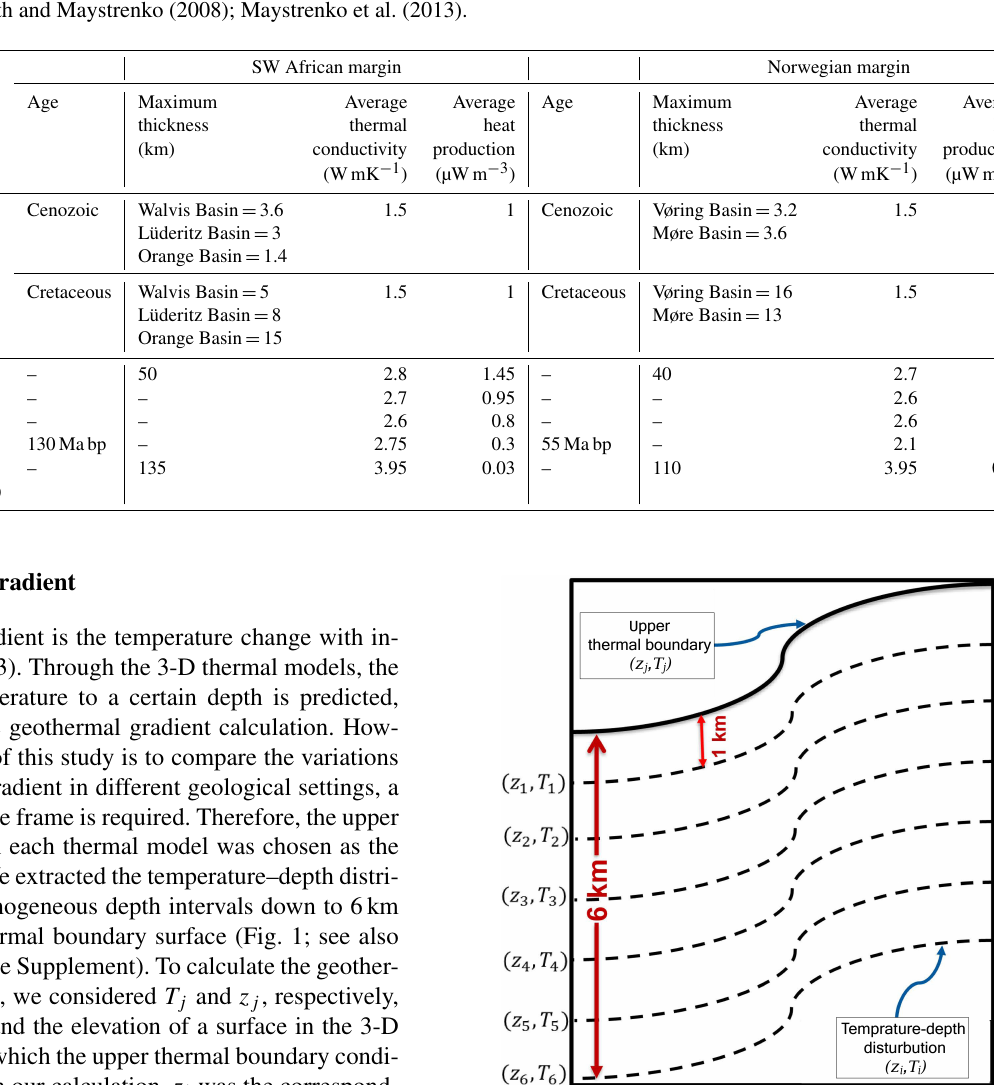
Table 1. Oceanic lithosphere age after Müller et al. (2008) and average physical properties of geological units used for thermal modeling after Scheck-Wenderoth and Maystrenko (2008); Maystrenko et al. (2013).